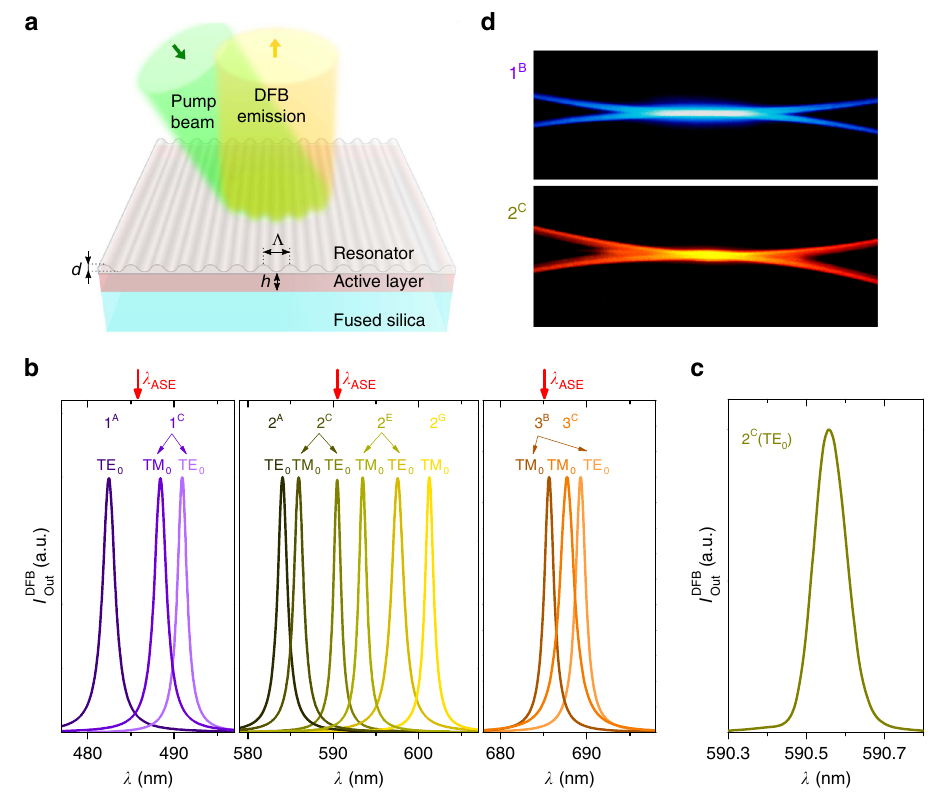
Fig. 2 Distributed feedback (DFB) laser architecture and spectral properties of nanographene lasers. a Sketch of the DFB device, consisting of a top-layer polymeric resonator with an engraved relief grating ( Λ , grating period; d , grating depth), located over an active fi lm ( h , fi lm thickness) of nanographene dispersed in polystyrene (PS), deposited on a fused silica substrate. The excitation and collection geometries are shown by arrows. b Spectra of DFB lasers based on nanographene-doped PS fi lms. The number on the device label refers to the nanographene molecule used among FZ1, FZ2, or FZ3; the letters on the labels refer to devices with different geometrical parameters (listed in Table 2). The emitted laser light consists of either one or two peaks (laser modes), each associated with a given waveguide mode of the fi lm, TE 0 or TM 0 , whose light is polarized parallel or perpendicular to the DFB grating lines, respectively. Top red arrows indicate the ASE wavelength for each case (exact values in Fig. 1b). c High-resolution spectrum of one of the laser peaks on an expanded scale (device 2 C , peak associated with the TE 0 waveguide mode). d Images of the total light emitted by devices 1 B and 2 C . Source data